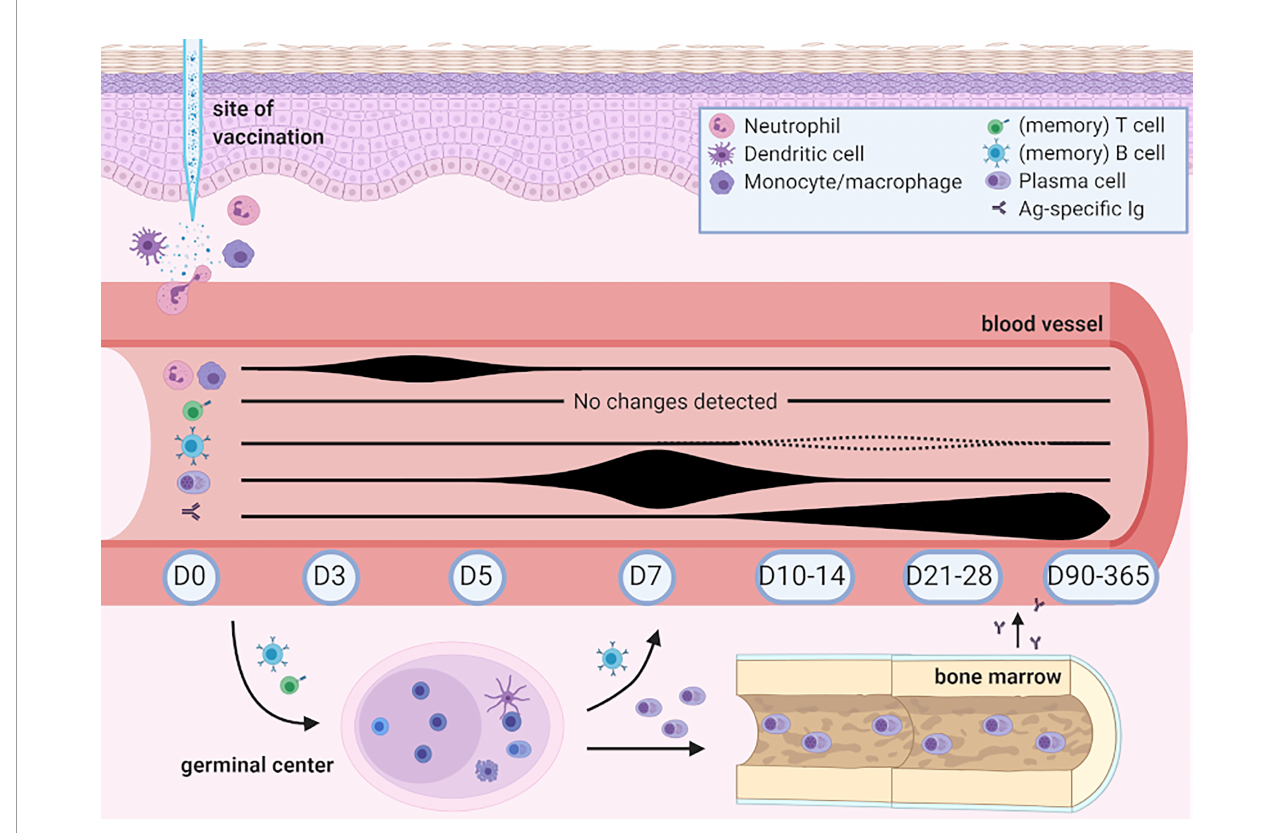
FIGURE 6 | Overview of changes detected in human peripheral blood post-Boostrix vaccination in this study. Created with BioRender.com. Up to 5 days post- vaccination, fl uctuations were found in the levels of circulating neutrophils and monocytes, with a change in total monocyte composition (based on expression of CD14 and CD16, with increased levels of intermediate and non-classical monocytes). Circulating plasma cells started expanding from day 5 onwards with a sharp peak in (predominantly IgG1) plasma cell levels at day 7 simultaneous with plasma cell maturation. Changes in circulating memory B-cell numbers were limited. Increase in Ag- speci fi c IgG serum levels occurred from day 7 onwards and only showed signs of waning at day 365. Despite in-depth analysis, no uniform changes were detected in circulating T-cell subsets. Baseline cell count and Ag-speci fi c serum Ig levels did not seem to in fl uence the levels of Ag-speci fi c